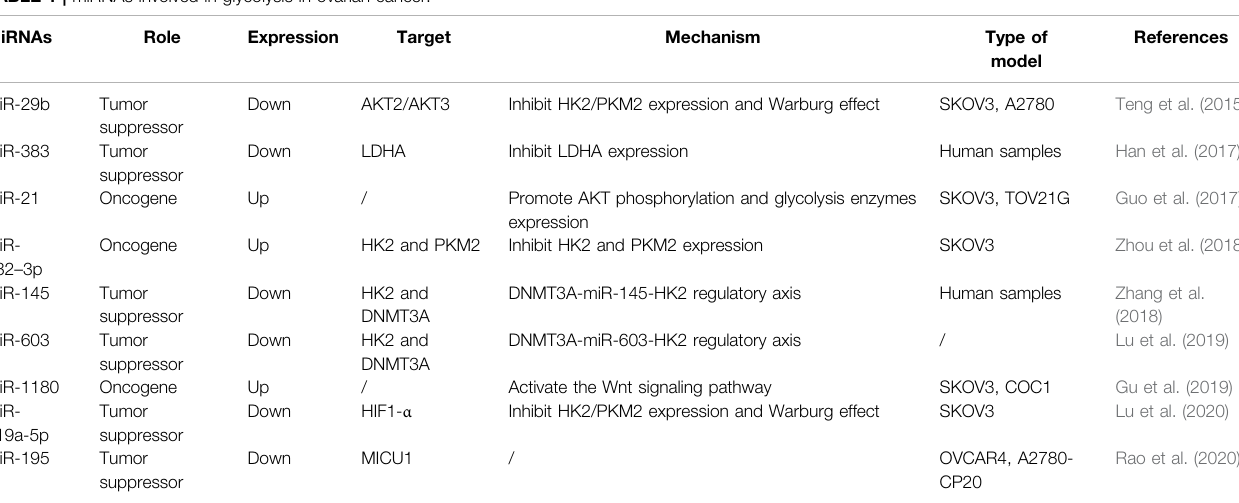
TABLE 1 | miRNAs involved in glycolysis in ovarian cancer.